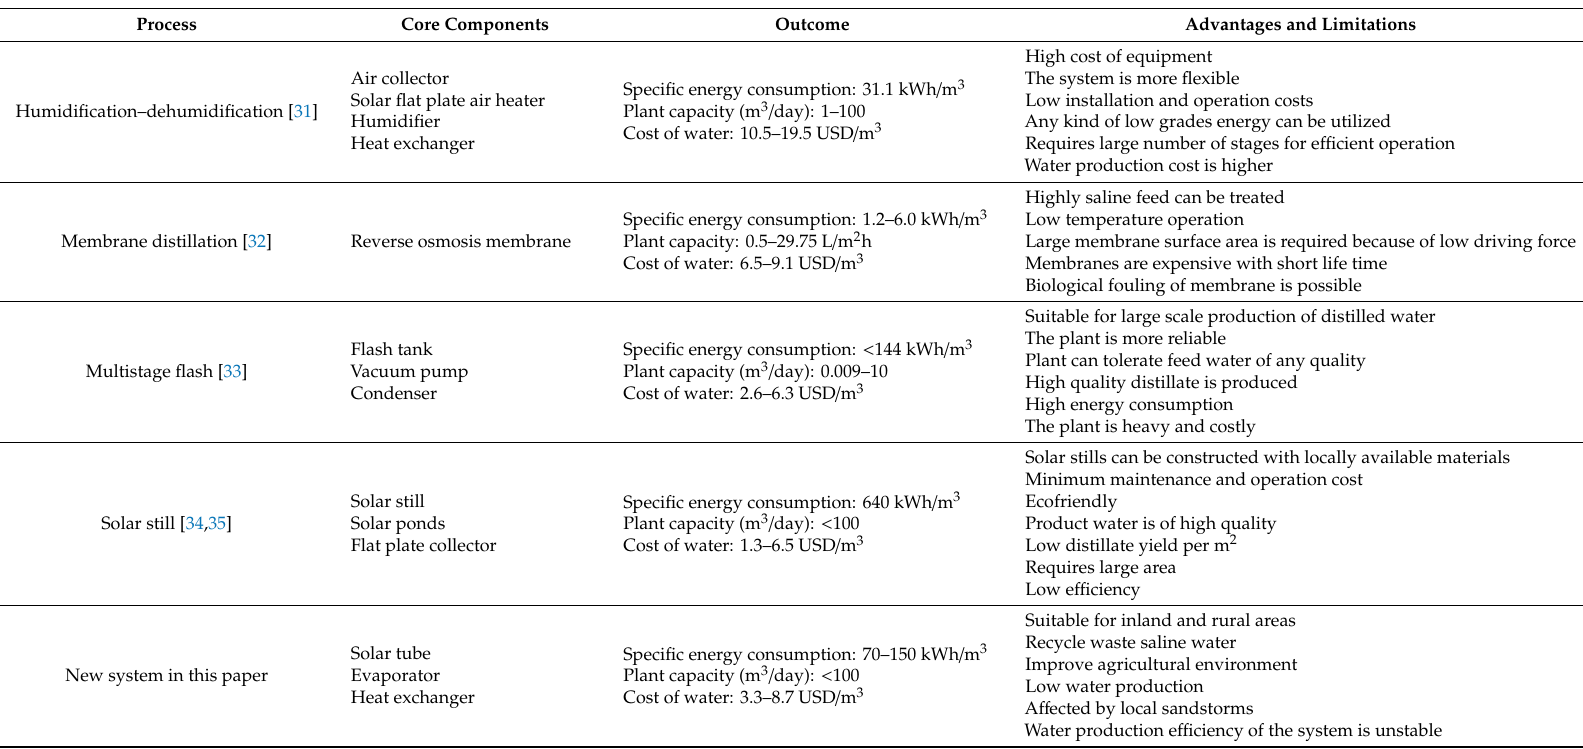
Table 3. Comparison of conventional